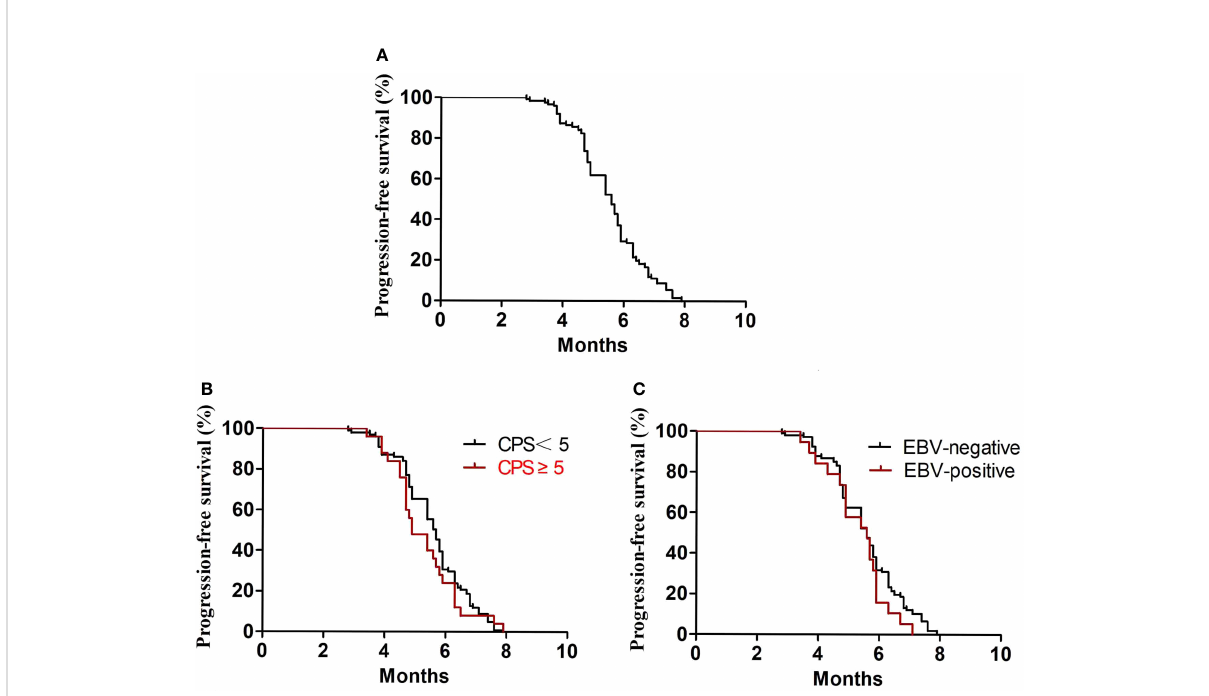
FIGURE 2 PFS2. (A) Kaplan – Meier plots for PFS2 in the second-line treatment. (B) PFS2 according to PD-L1 (P = 0.36). (C) PFS2 according to EBV (P = 0.46).